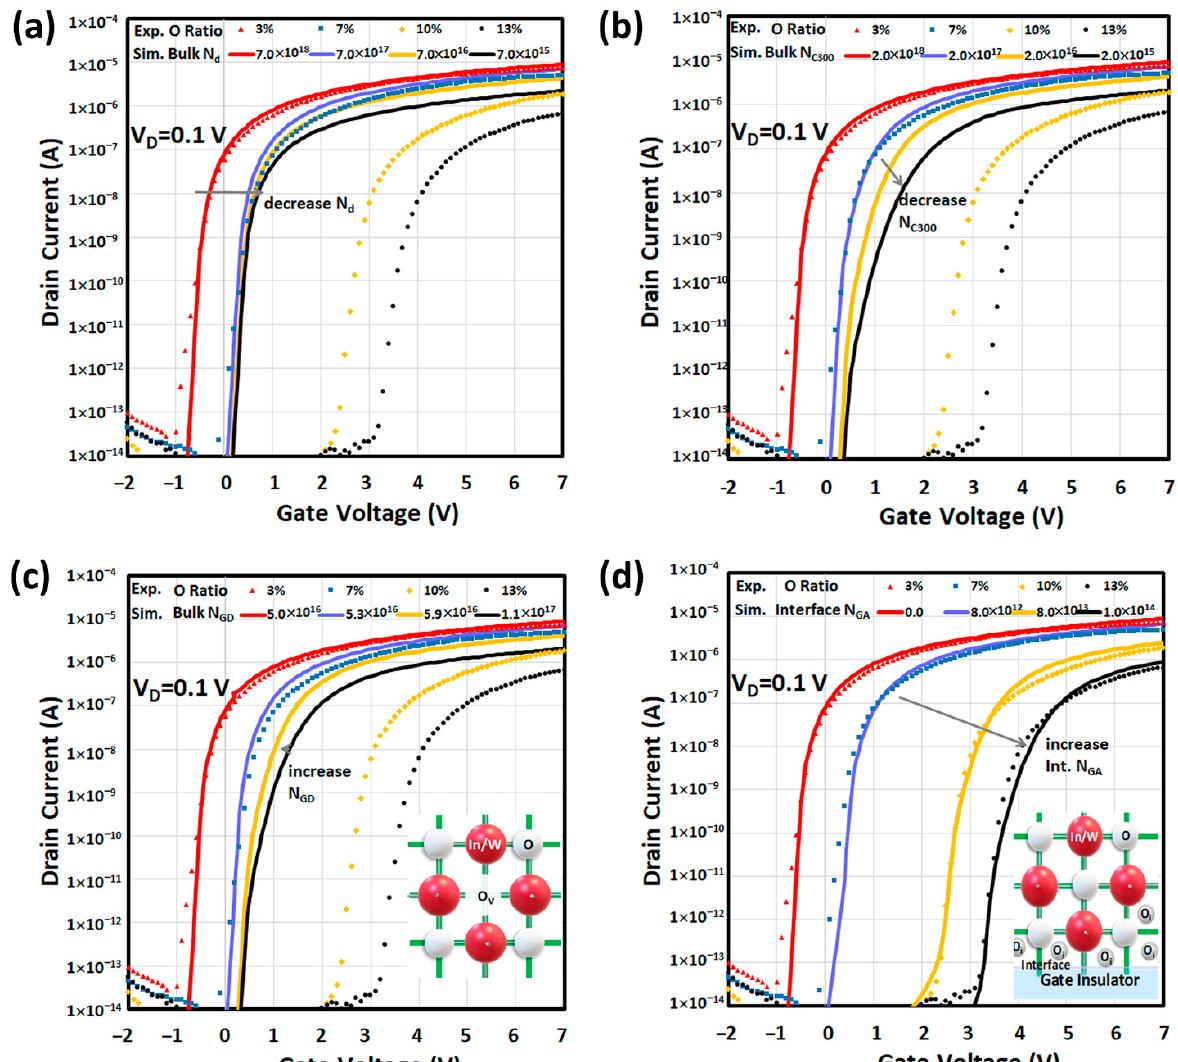
Figure 3. Simulated I D –V G curves affected by ( a ) bulk dopant concentration N d , ( b ) bulk conduction band carrier concentration N C , ( c ) bulk density of Gaussian donor trap N GD , and ( d ) front interface density of Gaussian acceptor trap N GA .